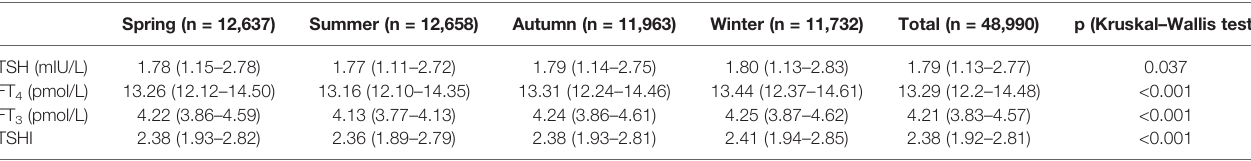
TABLE 1 | Comparisons of median TSH, FT 3 , FT 4 and TSHI concentrations in four seasons.